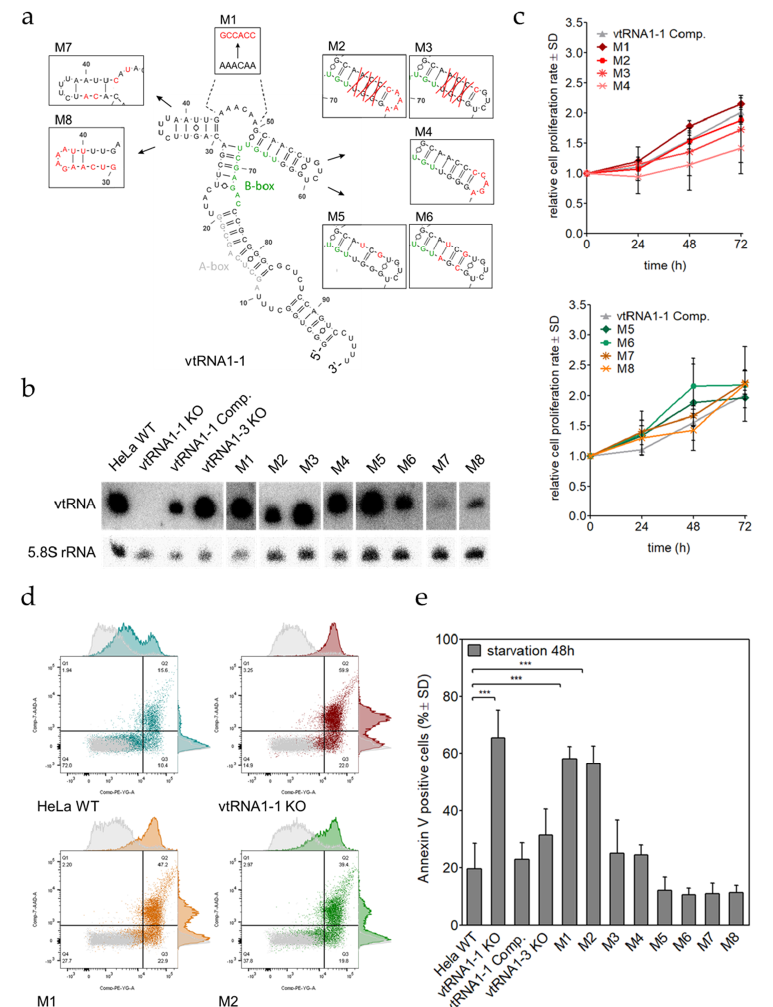
Figure 6. Twenty-four nucleotides within the vtRNA1-1 central domain are sufficient for apoptosis resistance. ( a ) A secondary structure model of vtRNA1-1 together with the schematic depiction of eight different mutations that were individually generated and by lentiviral transduction stably expressed in the endogenous vtRNA1-1 negative background of the vtRNA1-1 knock-out cell line. ( b ) The expression levels of M1 to M8 in HeLa vtRNA1-1 knock-out cells were confirmed by northern blot analysis with an oligonucleotide that was able to detect all vtRNA variants except M1, M7, and M8. For these mutants, individual DNA probes were designed. The 5.8S rRNA served as internal loading control. ( c ) Growth curve over 72 h, measured with the MTT proliferation assay of all mutant HeLa cell line derivatives. The vtRNA1-1 complementation cell line served as growth control. MTT assay data shows the normalized mean values and the standard deviation from triplicates. ( d ) After 48 h of starvation with chloroquine, HeLa cells expressing the mutant vtRNAs were stained with Annexin V and 7-AAD and apoptotic cells were quantified by FACS. The scatter plots depict HeLa WT, vtRNA1-1 knock-out, vtRNA M1, and vtRNA M2 cells without treatment (grey) and after 48 h of starvation with chloroquine (color). Quadrant 4 (Q4) represents unstained, viable cells, quadrant 3 (Q3) contains Annexin V positive, early apoptotic cells and quadrant 2 (Q2) gates Annexin V/7-AAD double-stained late apoptotic cells. ( e ) Quantification of Annexin V positive cell populations of the HeLa cells expressing vtRNA1-1 mutants after 48 h of starvation with chloroquine. HeLa WT, vtRNA1-1 knock-out, vtRNA1-1 complementation, and vtRNA1-3 knock-out cells served as apoptosis controls. The mean values andstandarddeviationsofthreeindependentexperimentsareshown. TheAnnexinVpositivecellfractionsof the untreated control cells were used to normalize the starvation samples and was usually < 10%. Significant differences were determined using the two-tailed unpaired Student’s t -test *** p <